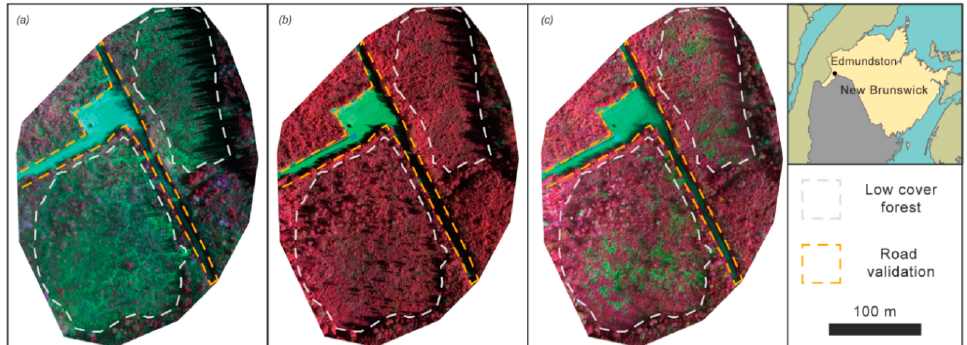
Figure 2. Study area on ( a ) 25 May 2017 (day of year: 145), ( b ) 27 June 2017 (day of year: 178), and ( c ) 15 September 2017 (day of year: 258), displaying the low cover forest area used for DTM analysis and road validation area. The smaller, upper-most portion of the low cover forest area is comprised of short understory regeneration, while the larger section is sparsely forested with approximately 50 stems per hectare. Imagery used was acquired using a Sequoia multi-spectral camera and is displayed in a false colour composite of near infra-red, red, and